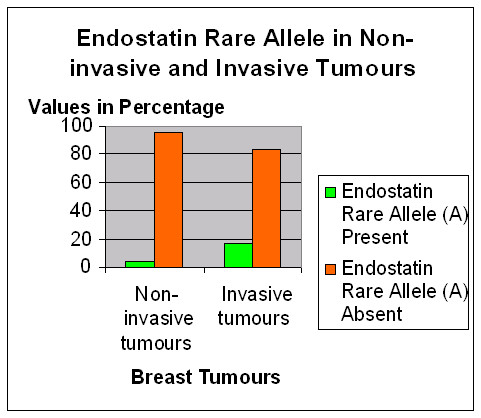
Distribution of the Endostatin Rare Allele (4349A) in patients with non-invasive and invasive tumours. The Rare allele was present in 2 of 44 patients with non-invasive tumours (4.5%) and 130 of 784 patients with invasive tumours (16.6%). Chi square test for trend; p = 0.033.